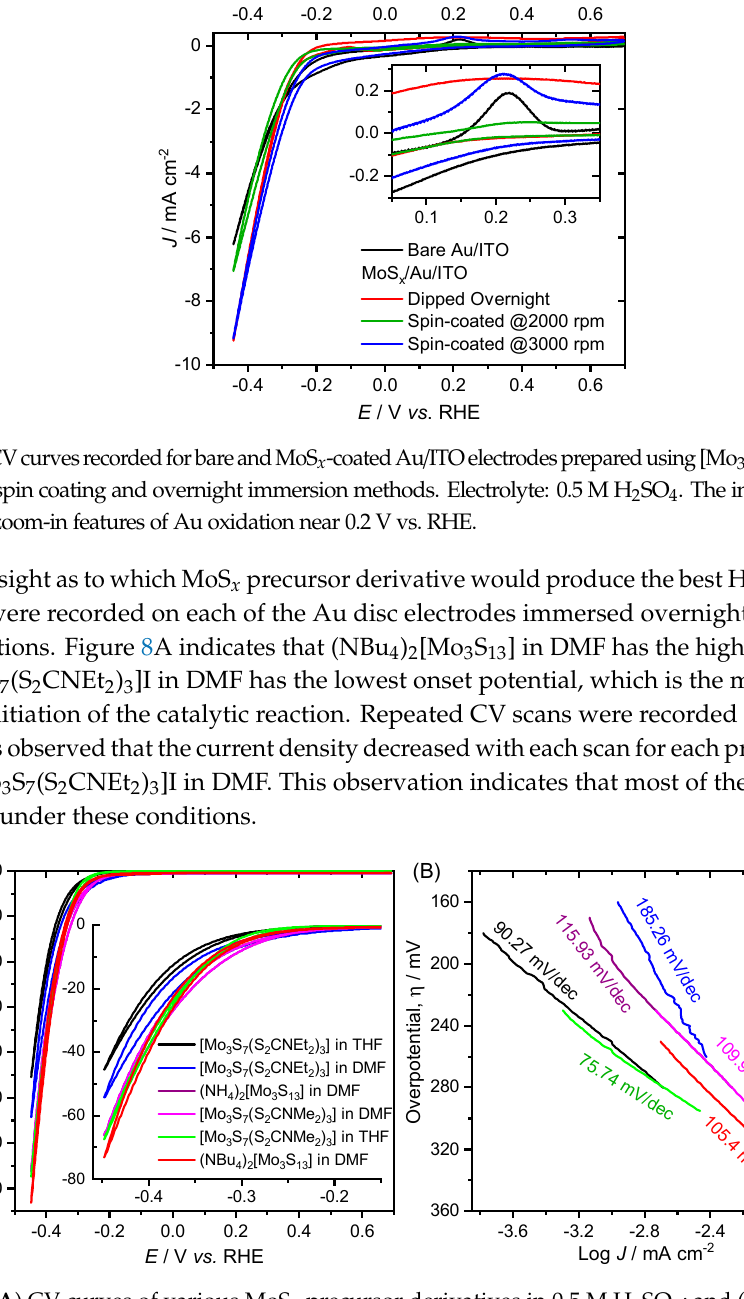
Figure 8. ( A ) CV curves of various MoS 2 precursor derivatives in 0.5 M H 2 SO 4 ; and ( B ) Tafel plot of MoS x derivatives derived in Figure 8A.